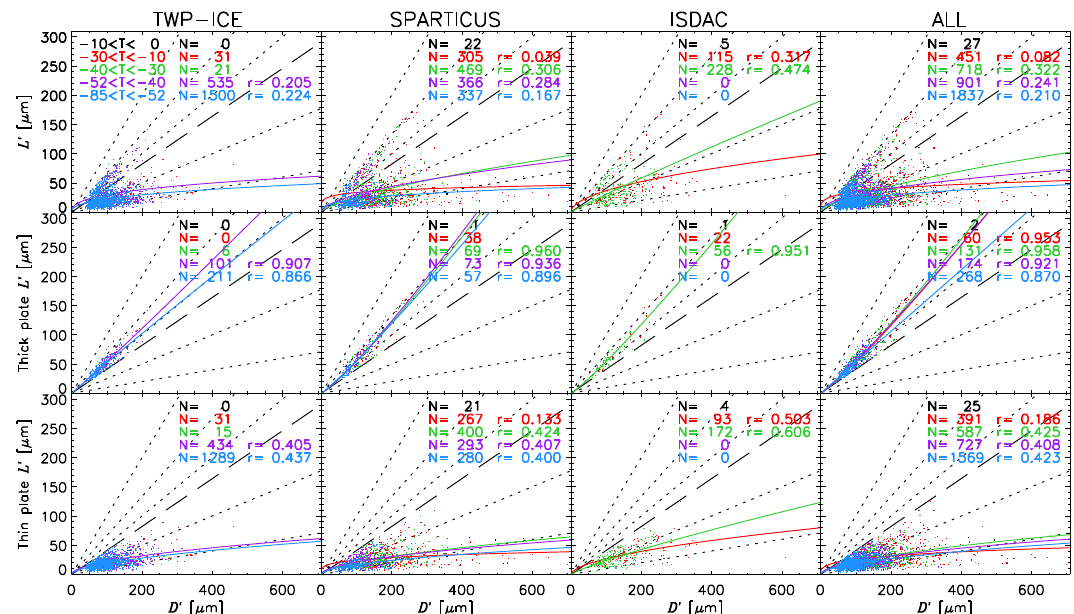
Figure 10. The D (cid:48) – L (cid:48) relationship of all plates (top row), thick plates (second row), and thin plates (third row) as a function of T . A black long-dashed line ( L (cid:48) /D (cid:48) = 0 . 41) by which thick and thin plates are categorized is shown in each panel.